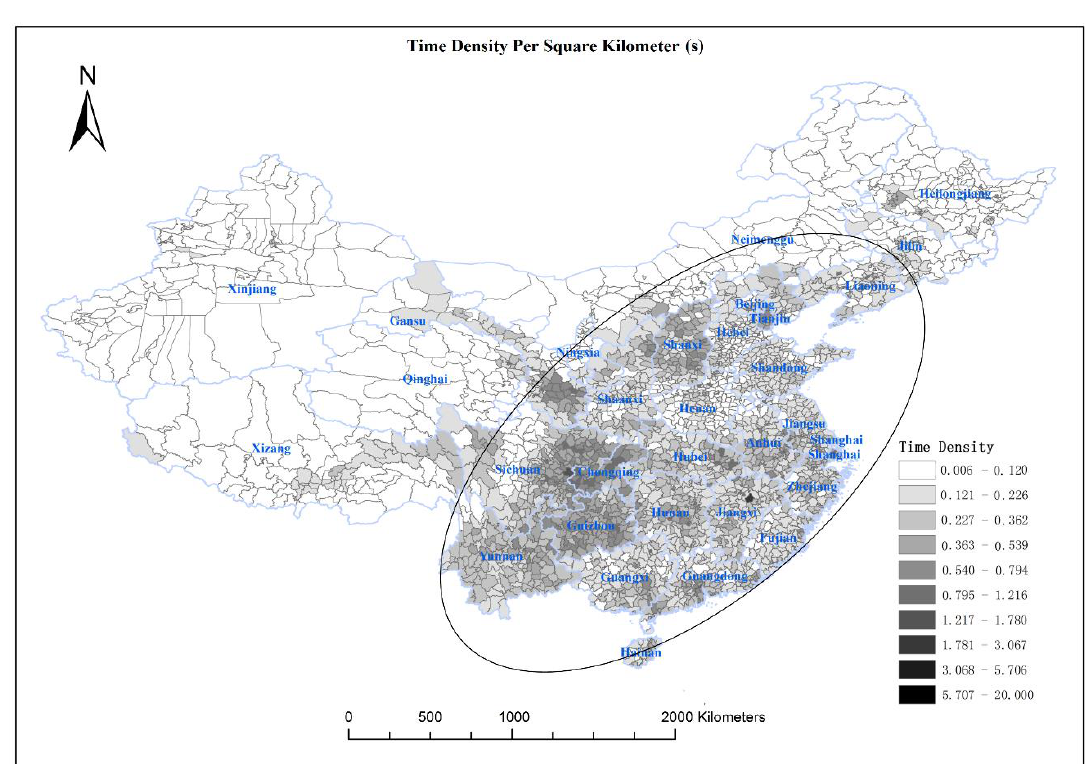
Figure 11. Estimated time density for the counties in China.